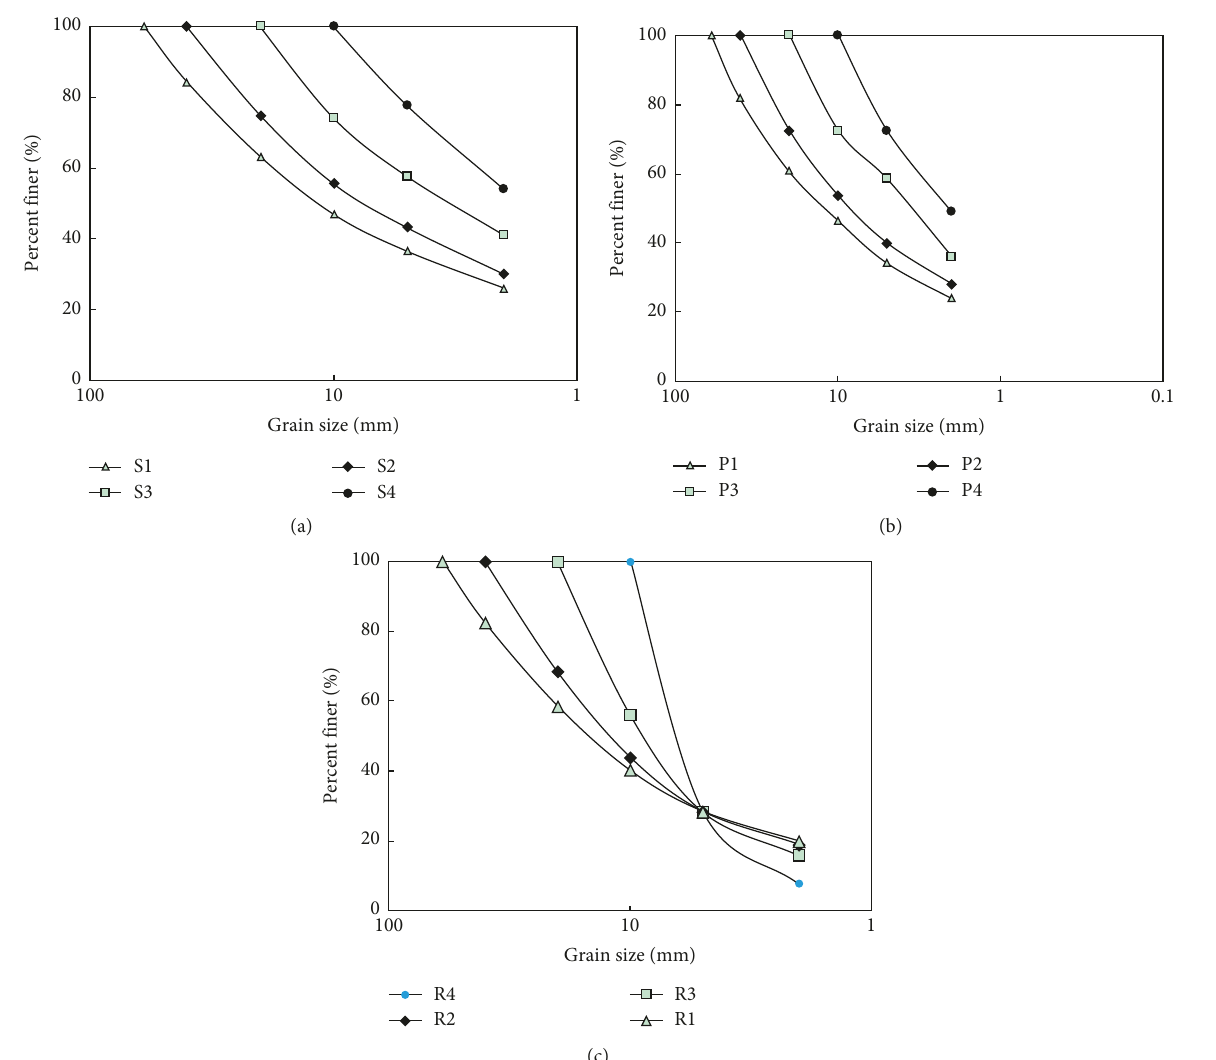
Figure 3: Grain size distribution (PSD) curves of tested materials. (a) S1 ∼ S4, (b) P1 ∼ P4, and (c) R1 ∼